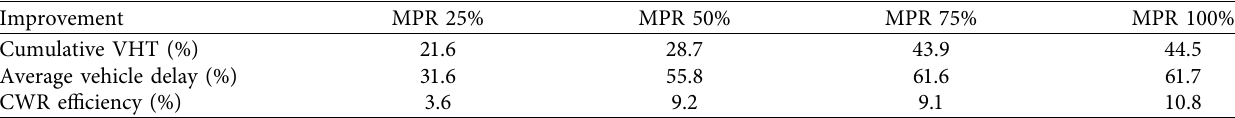
Figure 8: Efect of CWR control of the entire network. (a) cumulative VHT. (b) Average vehicle delay. Table 9: Efect of CWR intersection signal control: entire road network.